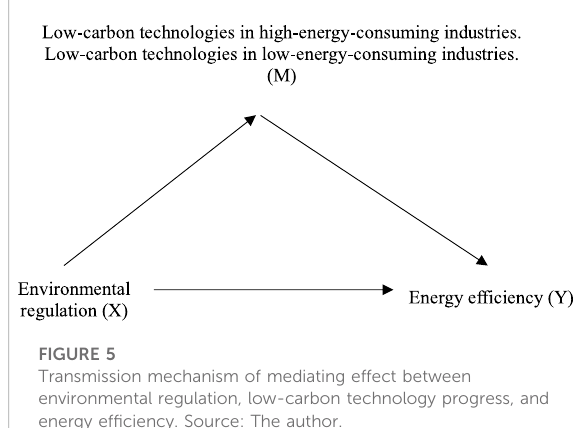
FIGURE 5 Transmission mechanism of mediating effect